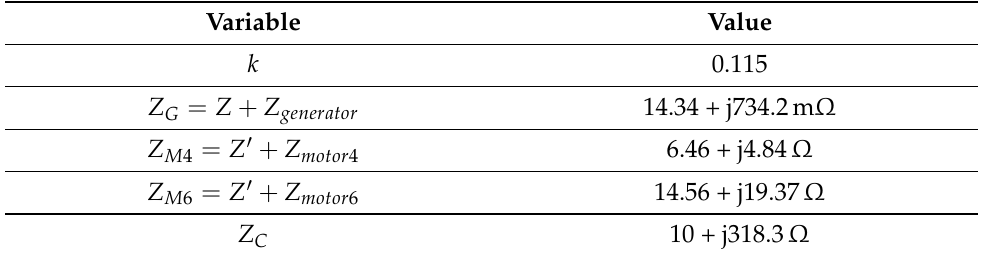
Table 3. Simulation values to plot the Bode diagram of Figure 8.